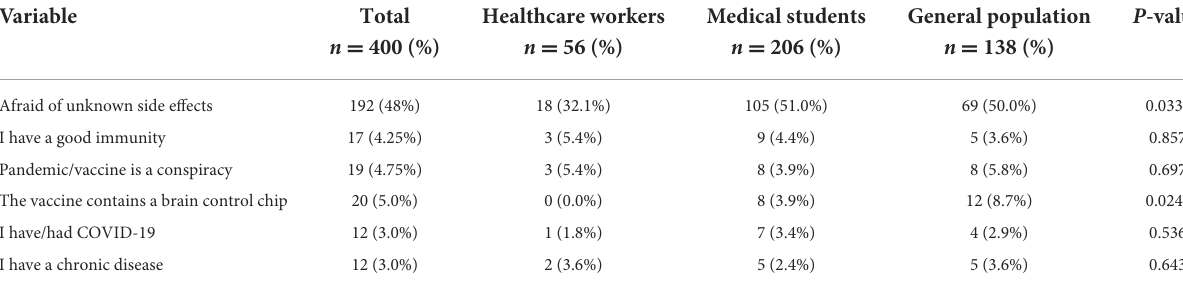
TABLE 5 Barriers to vaccine acceptance by population